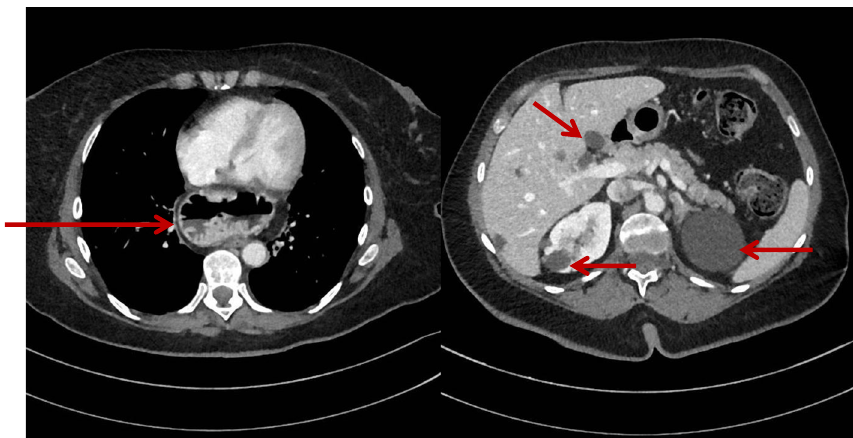
Fig. 1 Abdominal CT scan showing a polycystic hepatorenal disease and hiatal hernia, with no abnormalities of the pancreatic